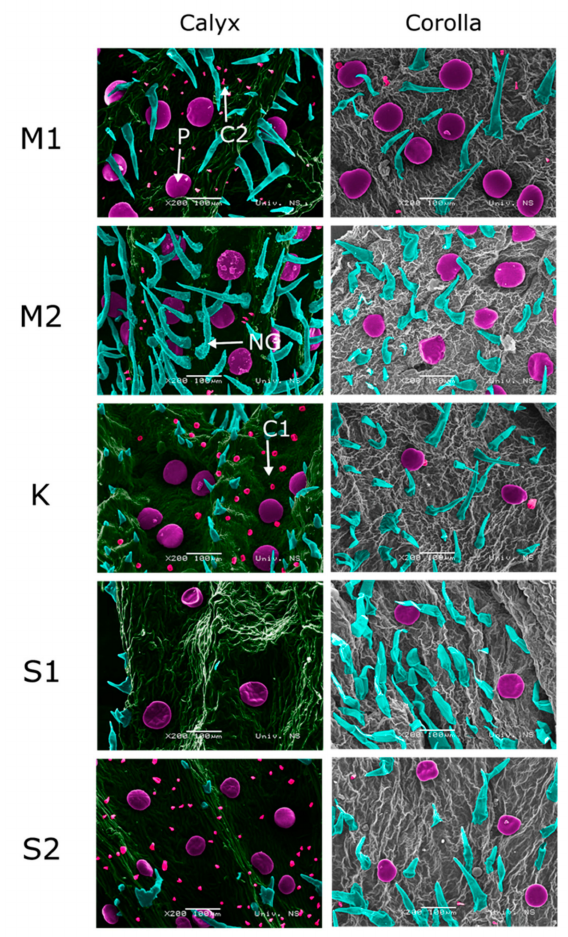
Figure 3. Scanning electron micrographs of M1: S. montana continental; M2: S. montana coastal; K: S. kitaibelii ; S1: S. subspicata subsp. liburnica ; S2: S. subspicata subsp. subspicata calyces and corollas. P: Peltate trichomes; C1: Type 1 capitate trichomes; C2: Type 2 capitate trichomes; NG: